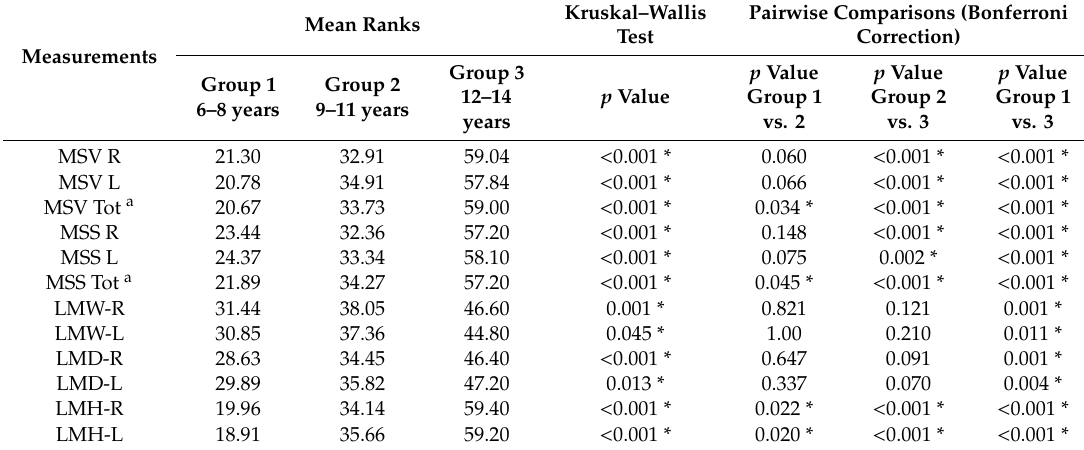
Table 2. Comparisons between groups in female subjects.